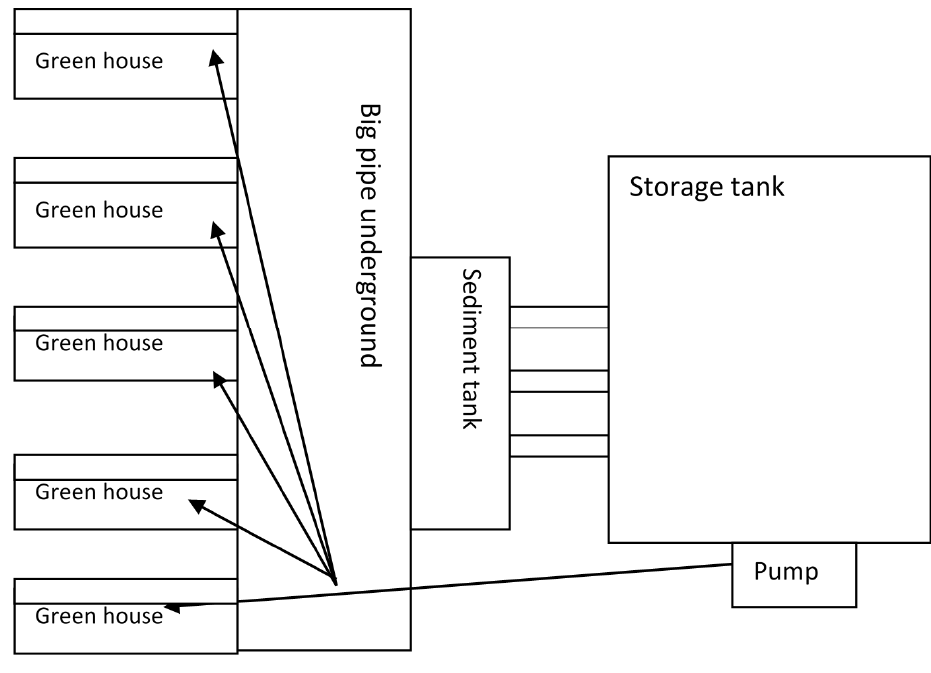
Figure 2. A RWH system [7].